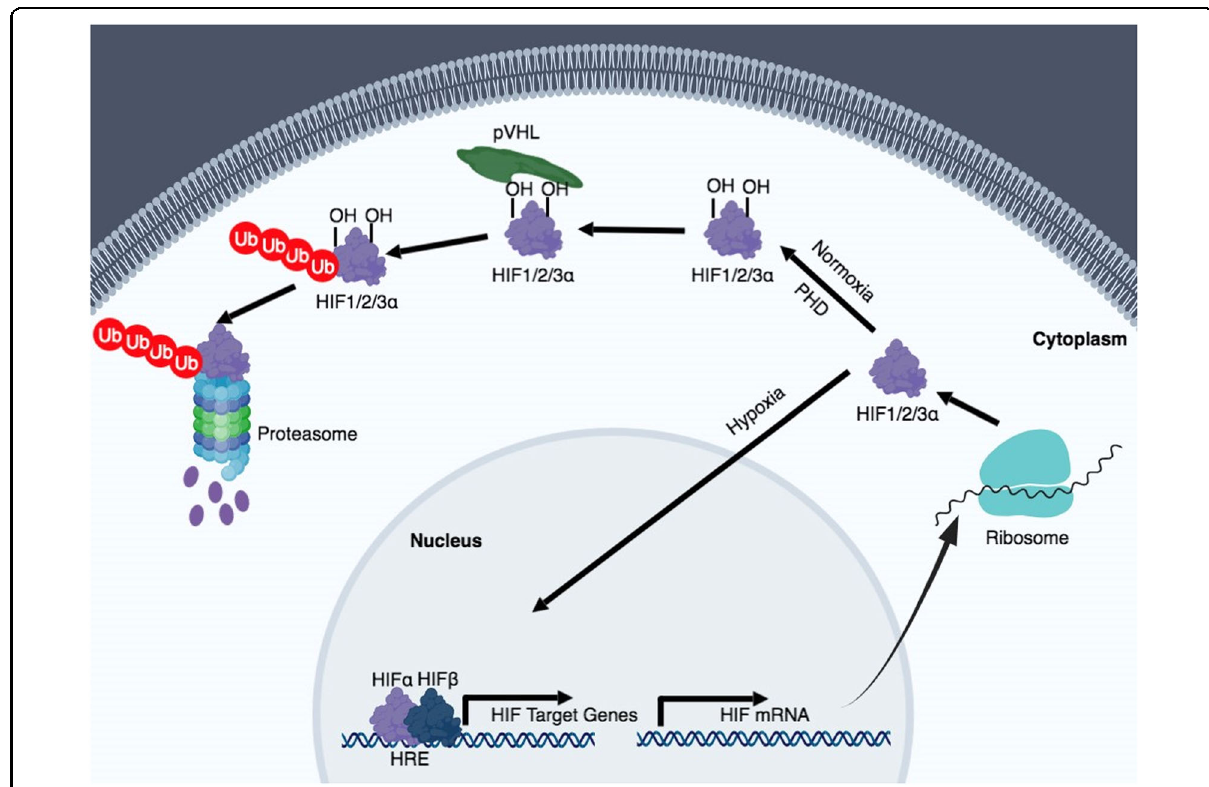
Fig. 1 Hypoxia-inducible factor (HIF) regulation during normoxia and hypoxia. In oxygenated conditions, HIF is hydroxylated on proline residues by prolyl-4-hydroxylases (PHDs) and polyubiquitinated by the von Hippel – Lindau protein (pVHL). This leads to degradation of HIF by the 26S proteasome system. In hypoxic conditions, HIF is stabilized and translocated into the nucleus, where it binds to its dimerization partner HIF1B and enhances the transcription of HIF target